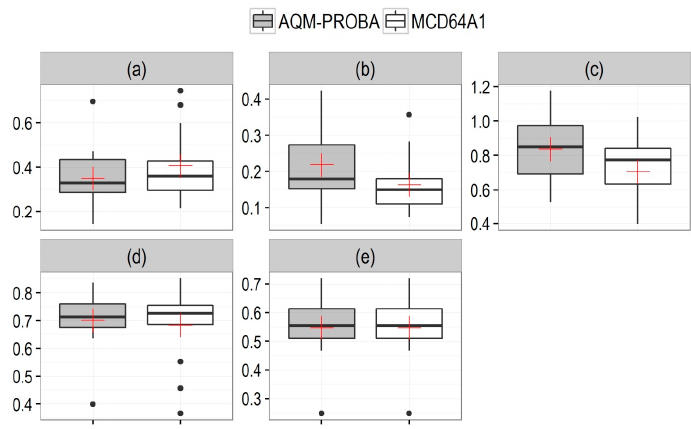
Figure 4. Boxplots for each verification measures ( a ) Omission Error (OE); ( b ) Comission Error (CE); ( c ) Bias (BIAS); ( d ) Dice Coefficient (DICE) and ( e ) Critical Success Index (CSI) for 13 Landsat 8 scenes based on Área Queimada —Project for On-Board Autonomy-Vegetation burned area product (AQM-PROBA) (gray boxes) and Moderate Resolution Imaging Spectroradiometer direct broadcast (DB) burned area product (MCD64A1) (white boxes), depicting the 25th, 50th (median, black line) and 75th percentiles. The red cross represents the mean value, and black points are the outliers. Table 4. Verification measures from contingency table (Omission Error (OE); Comission Error (CE); Bias (BIAS); Dice Coefficient (DICE) and Critical Success Index (CSI)) for Área Queimada —Project for On-Board Autonomy-Vegetation burned area product (AQM-PROBA) and Moderate Resolution Imaging Spectroradiometer direct broadcast (DB) burned area product (MCD64A1) for each Landsat 8 scene. Products